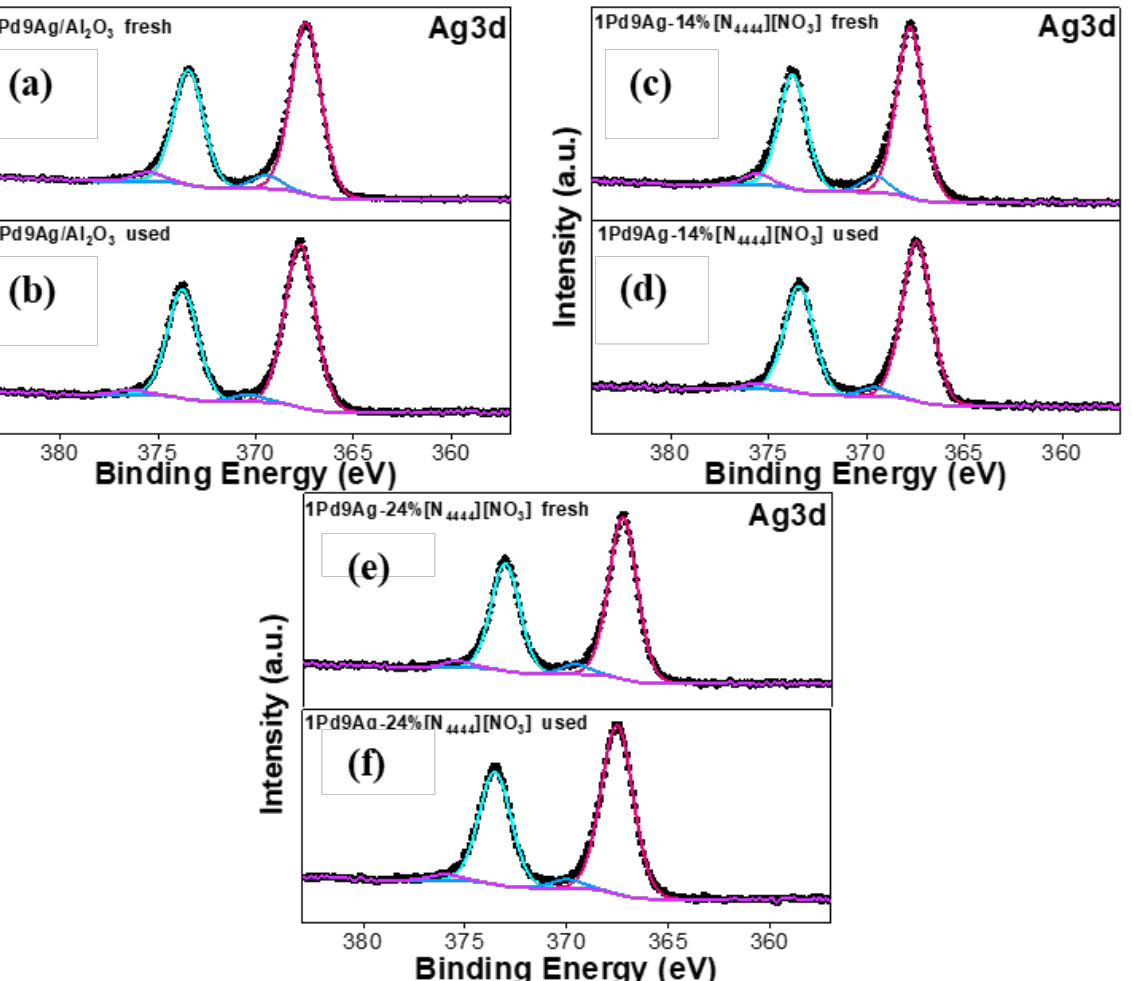
Figure 10. Ag 3d XP spectra for the fresh and used catalysts: fresh 1Pd9Ag/Al 2 O 3 ( a ), used 1Pd9Ag/Al 2 O 3 ( b ), fresh 1Pd9Ag-14%[N 4444 ][NO 3 ] ( c ), used 1Pd9Ag-14%[N 4444 ][NO 3 ] ( d ), fresh 1Pd9Ag-24%[N 4444 ][NO 3 ] ( e ) and used 1Pd9Ag-24%[N 4444 ][NO 3 ] ( f ).Solid black curves represent the raw data. Fitted individual components are also shown by solid-coloured curves.